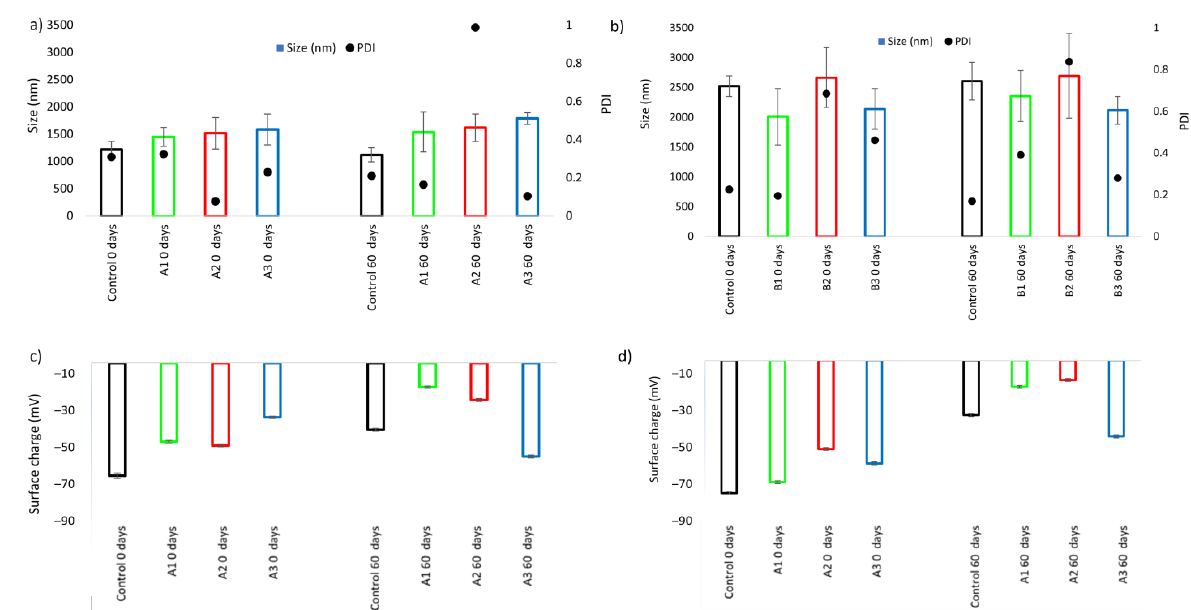
Figure 4. Variation in particle size and PDI ( a , b ) and surface charge ( c , d ) over 60 days of cosmetic formulations: ( a , c ) formulation A with the three incorporated extracts (A1, A2, and A3); ( b , d ) for- mulation B with the three incorporated extracts (B1, B2, and B3). ( b , d ) formulation B with the three incorporated extracts (B1, B2, and B3).